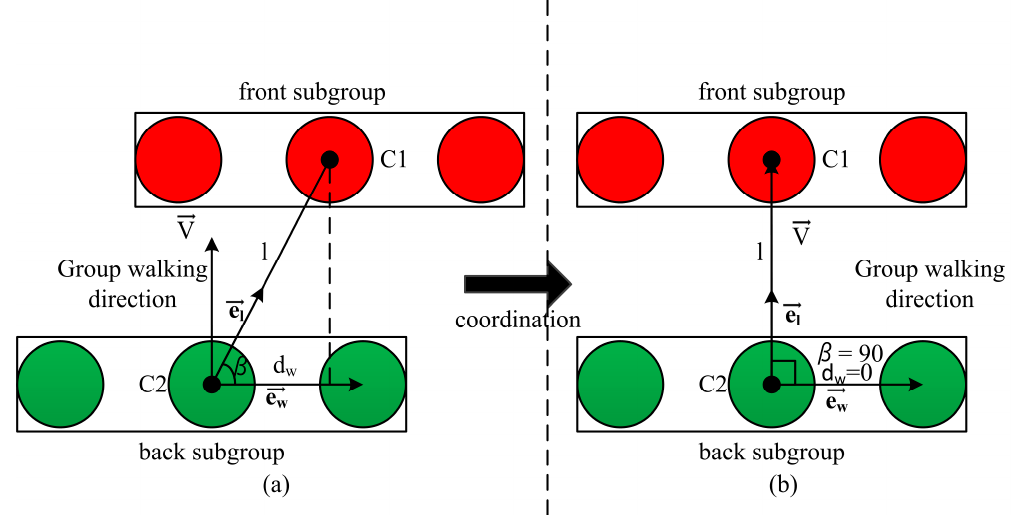
Figure 2. Illustration of subgroup coordinate behavior. ( a ) The state before coordination. The rear subgroup adjusts its direction to align the front subgroup if (cid:1856) (cid:3050) ≠ 0 and attempts to maintain an adequate distance. ( b ) The state after coordination is expressed as (cid:1856) (cid:3050) = 0,(cid:2010) = 90